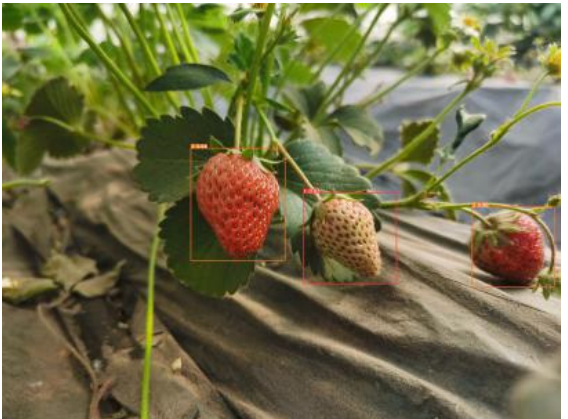
Figure 5. YOLOv5 strawberry maturity test renderings.